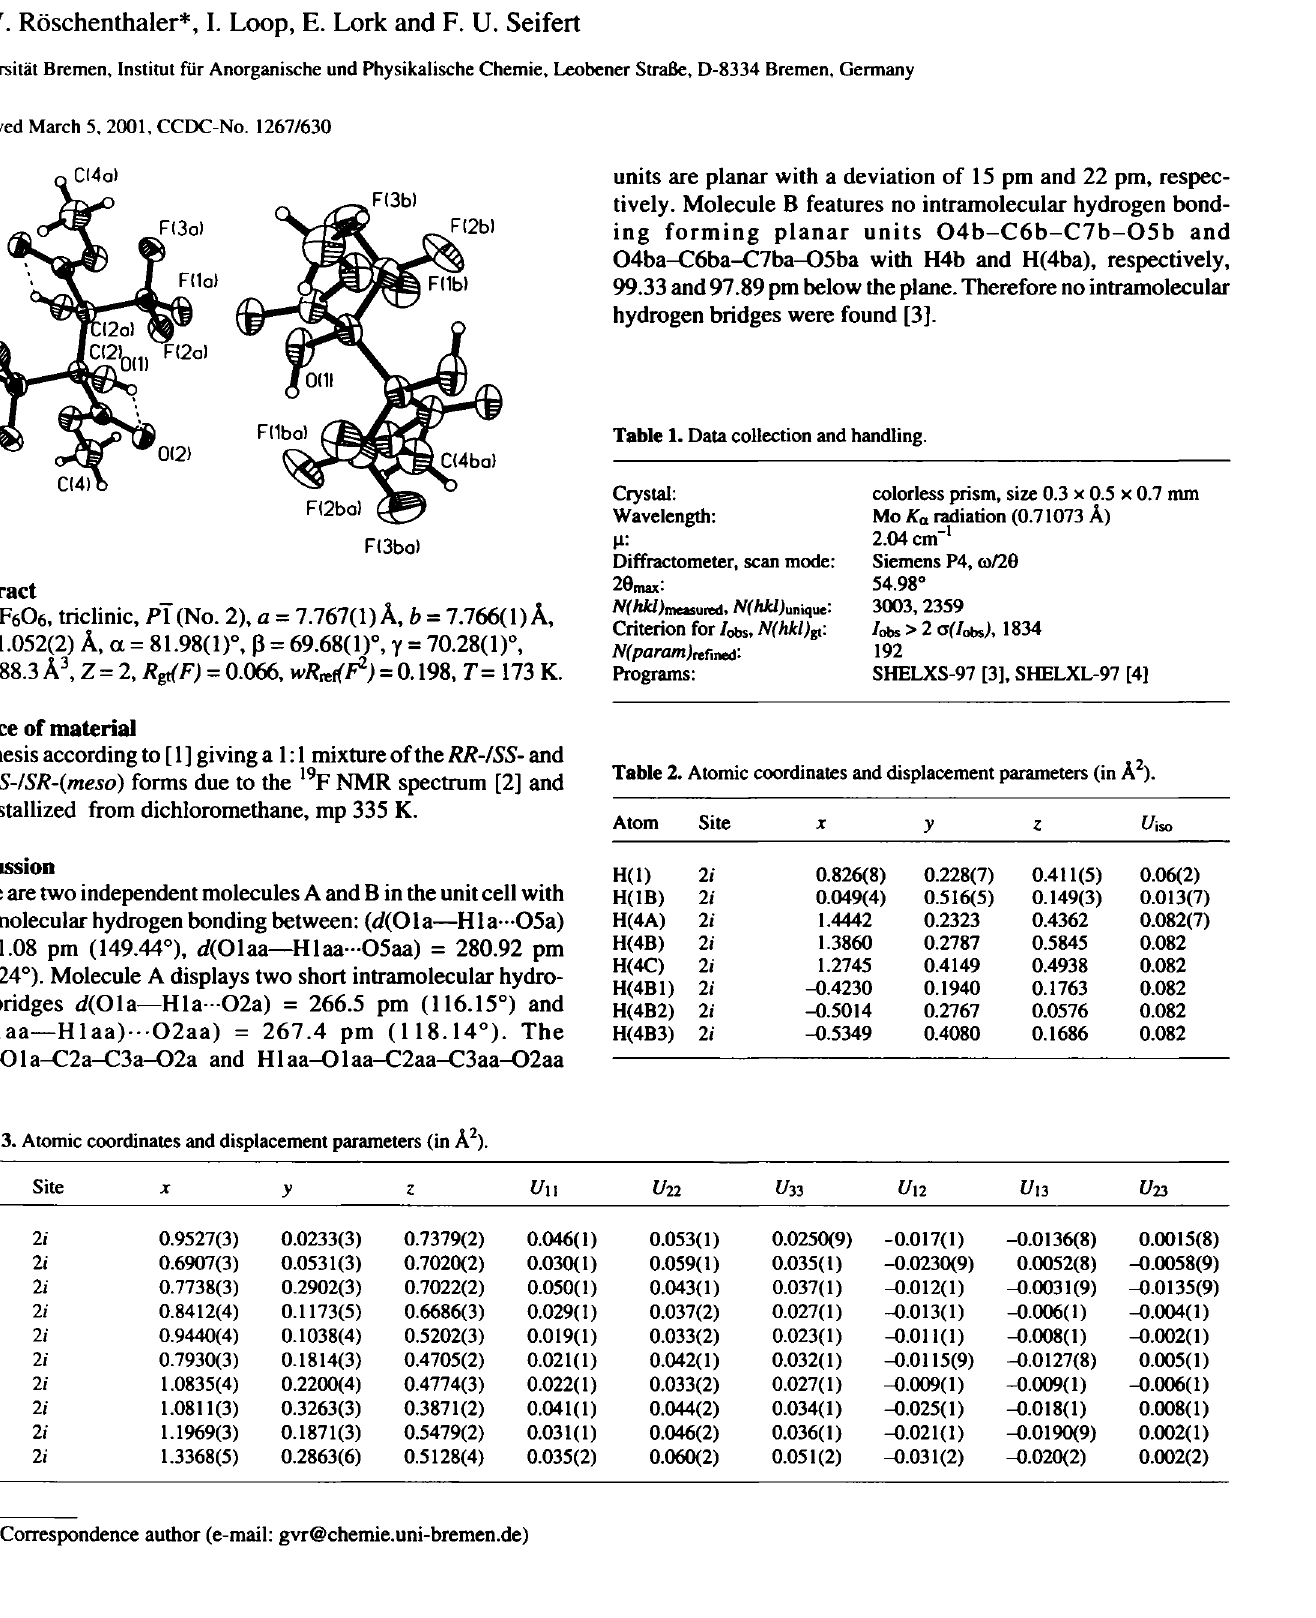
Table 1. Data collection and handling.